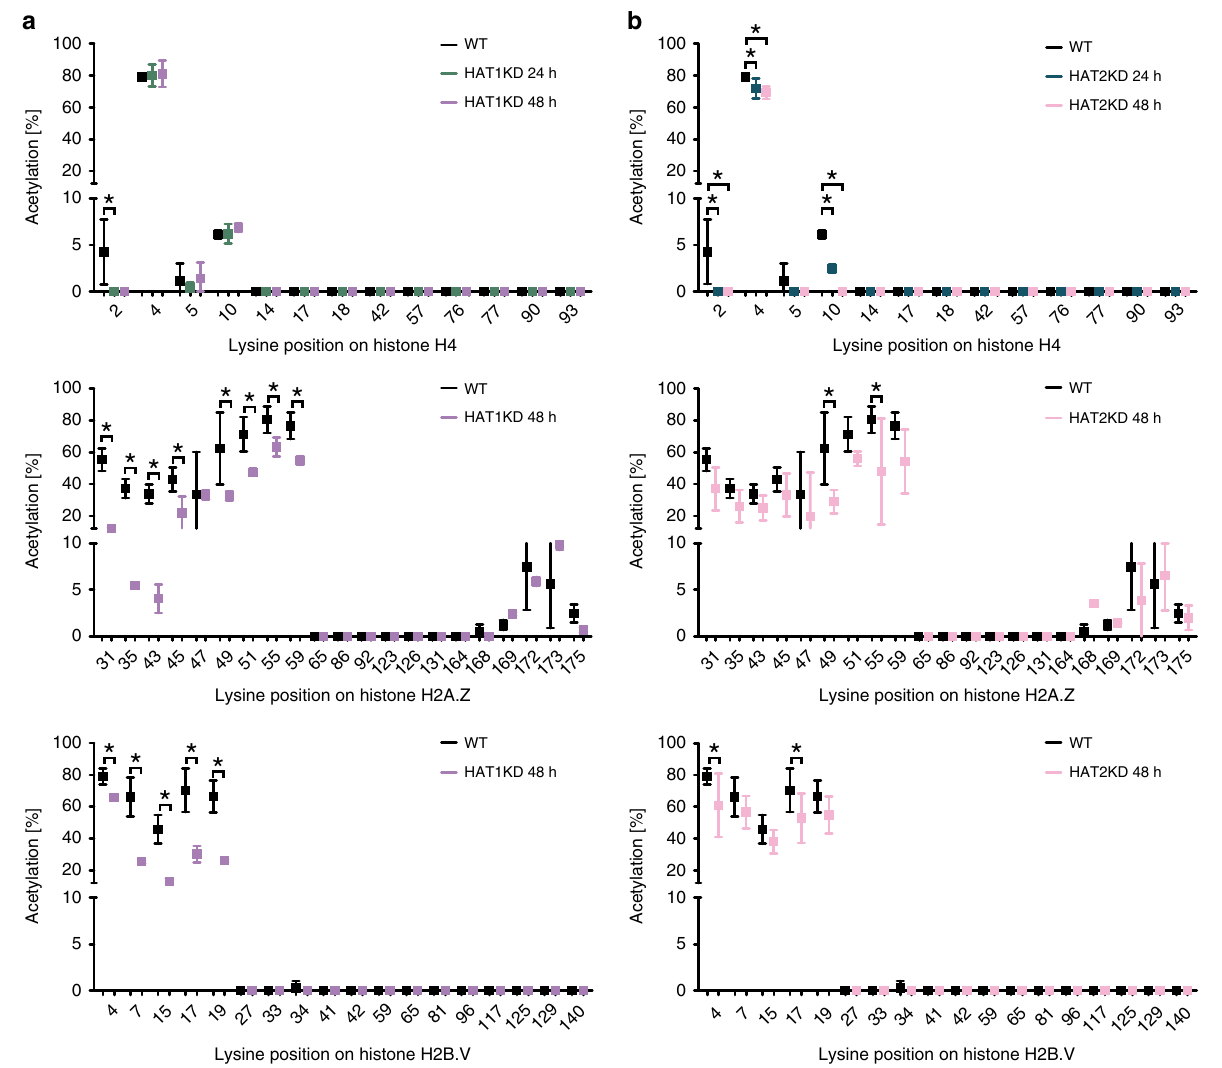
Fig. 5 HAT1 and HAT2 acetylate histones at TSSs. a Levels of lysine-speci fi c acetylation for H4, H2A.Z and H2B.V are shown for WT cells and after depletion of HAT1. H4 acetyl marks were quanti fi ed by FIPQuant using histones extracted from WT cells (black, n = 3) and from 2T1 cells, which were depleted of HAT1 for 24 h (green, n = 3) or 48 h (purple, n = 3). H2A.Z and H2B.V acetyl marks were quanti fi ed using histones from immunoprecipitated TSS-nucleosomes (black; n = 7) and 2T1 cells, depleted for HAT1 for 48 h (purple; n = 3). The acetylation percentages [%] represent the averages of the median values from each of the independent experiments determined by FIPQuant. Error bars indicate standard deviations. Supplementary Fig. 9a shows the data for each replicate. b Levels of lysine-speci fi c acetylation for H4, H2A.Z and H2B.V are shown for WT cells and after depletion of HAT2. H4 acetyl marks were quanti fi ed by FIPQuant using histones extracted from WT cells (black; n = 3) and from 2T1 cells, which were depleted of HAT2 for 24 h (blue; n = 3) or 48 h (rose; n = 3). H2A.Z and H2B.V acetyl marks were quanti fi ed using histones from immunoprecipitated TSS-nucleosomes of WT cells (black; n = 7) and 2T1 cells, depleted of HAT2 for 48 h (rose; n = 2). The acetylation percentages represent the averages of the median values from each of the independent experiments determined by FIPQuant. Error bars indicate standard deviations. Supplementary Fig. 9b shows the data for each replicate. Source data are provided as a Source Data fi le. Multiple t-tests between the different conditions were performed and individual p-values for each lysine position were computed using the two-way ANOVA approach. The statistical signi fi cance was determined using the Holm-Sidak method 77,78 and ‘ statistically signi fi cant ’ adjusted p -values ( p adj < 0.05) were marked with asterisks (exact p -values are listed in Supplementary Data